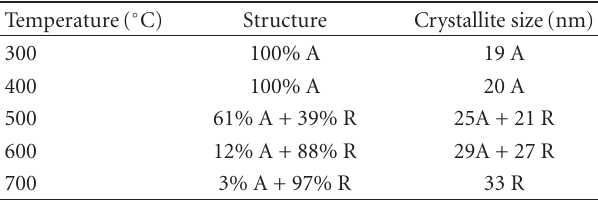
Table 1: Crystallite structure and size of TiO 2 calcined at di ff erent temperature.